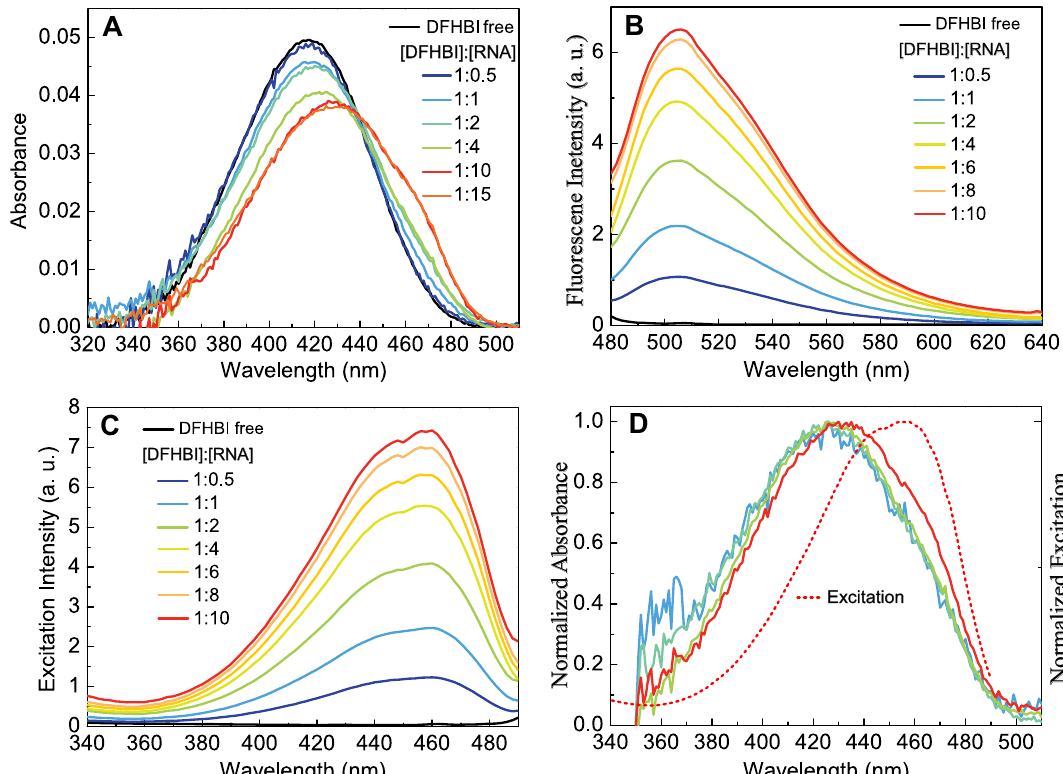
Figure 1. Absorption ( A ) and fluorescence ( B) spectra (λ exc 460 nm) of free DFHBI (2 µM) in the absence of bSP (black) and its mixture with increasing bSP concentrations, all measured in a flow-cell at low intensity. (C) Fluorescence excitation spectra (λ probe 501 nm) of free DFHBI and in the presence of increasing bSP concentrations. (D) Normalized calculated absorption spectra for increasing bSP concentrations as derived from K d = 4.4 µM in comparison with the fluorescence excitation spectrum (red,